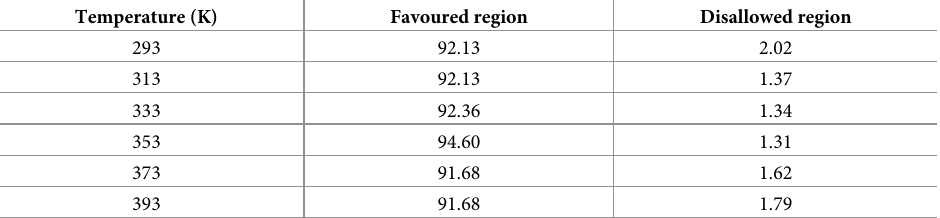
Table 2. Percentage occurence of residues in favoured and disallowed regions of SazCA, as obtained from the Ramachandran plot at various investigated